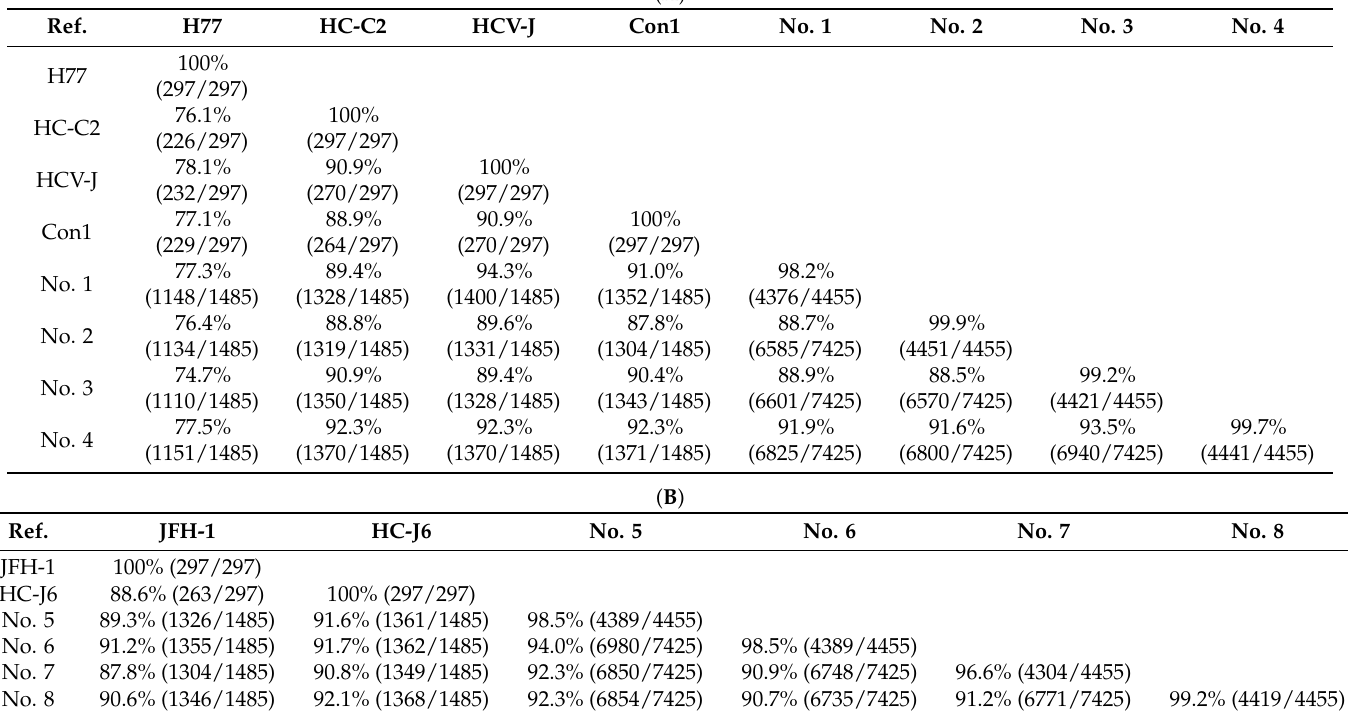
Table 4. Comparison between HCV NS4 nucleotide sequences obtained from discrepant samples and reference sequences (Ref.) specific for each genotype by cloned Sanger sequencing. ( A ) Identity between NS4 nucleotide sequences of genotype 1b obtained by sequencing (5 clones) and reference sequences of genotype 1 (1a and 1b); ( B ) Identity between NS4 nucleotide sequences of genotype 2a obtained by sequencing (5 clones) and reference sequences of genotype 2a; ( C ) Identity between NS4 nucleotide sequences of genotype 2b obtained by sequencing (5 clones) and reference sequences of genotype